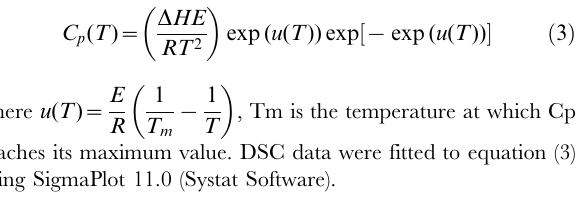
Table S2 Interactions of Subunits at Dimer and Tetramer Interfaces in MnSODs from Different Organisms. Table S3 Calculation of K d for K184R, L185P Ca